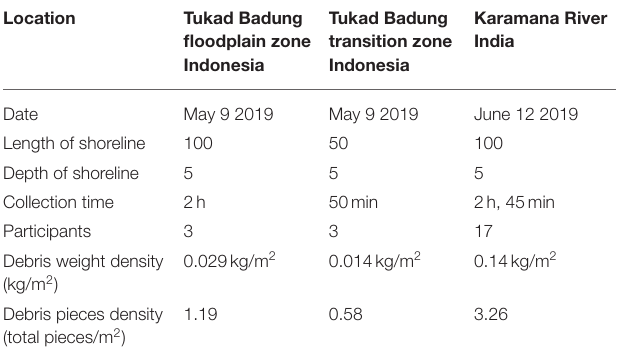
TABLE 1 | Compiled results from example